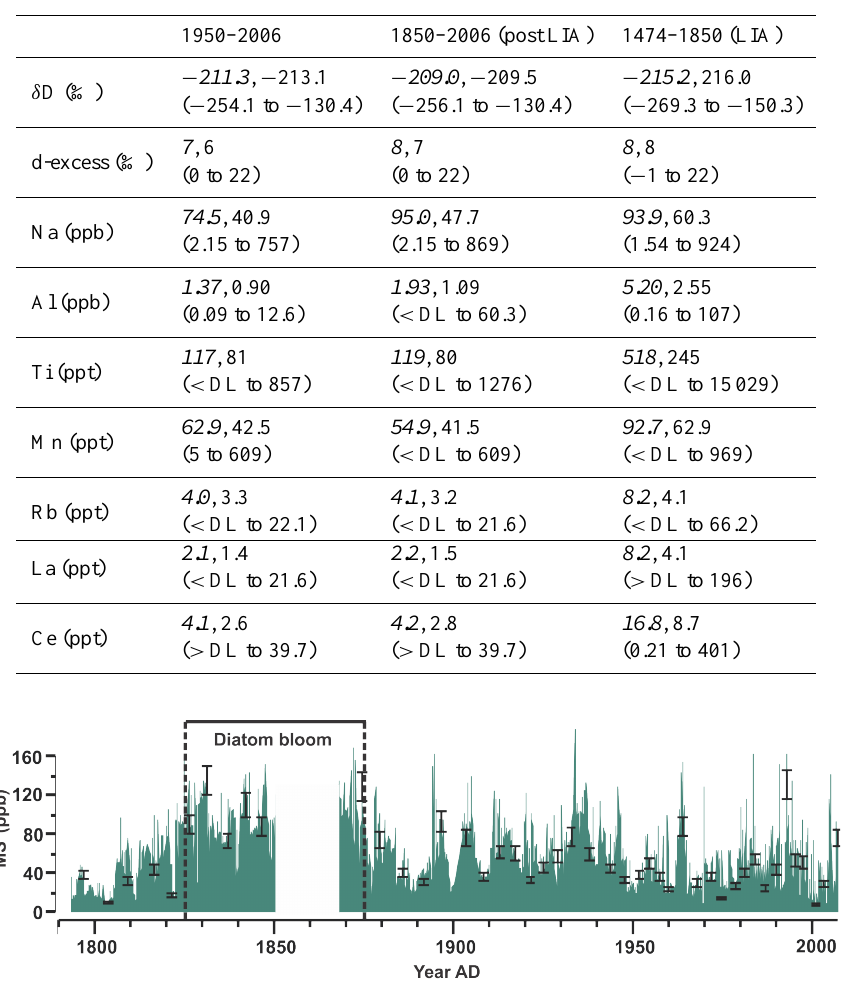
Table 2. Mean (italicised), median and range (in parentheses) of selected stable isotopic and chemistry parameters within specified time intervals of the MES ice core record. δ D and d-excess data measured by LGR laser instrument have been adjusted (Supplement).